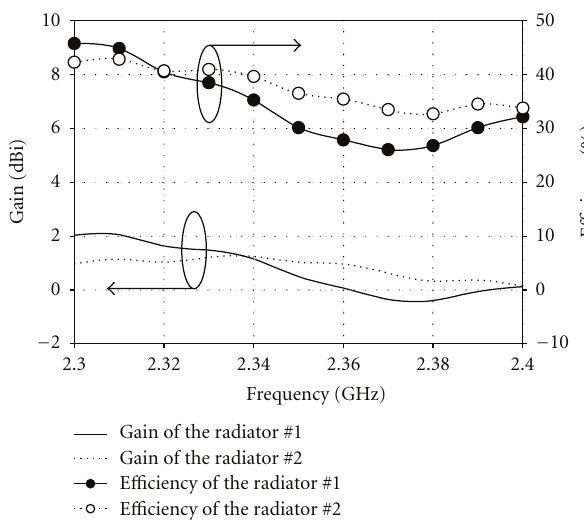
Figure 10: Measured gain and radiation e ffi ciency characteristics.